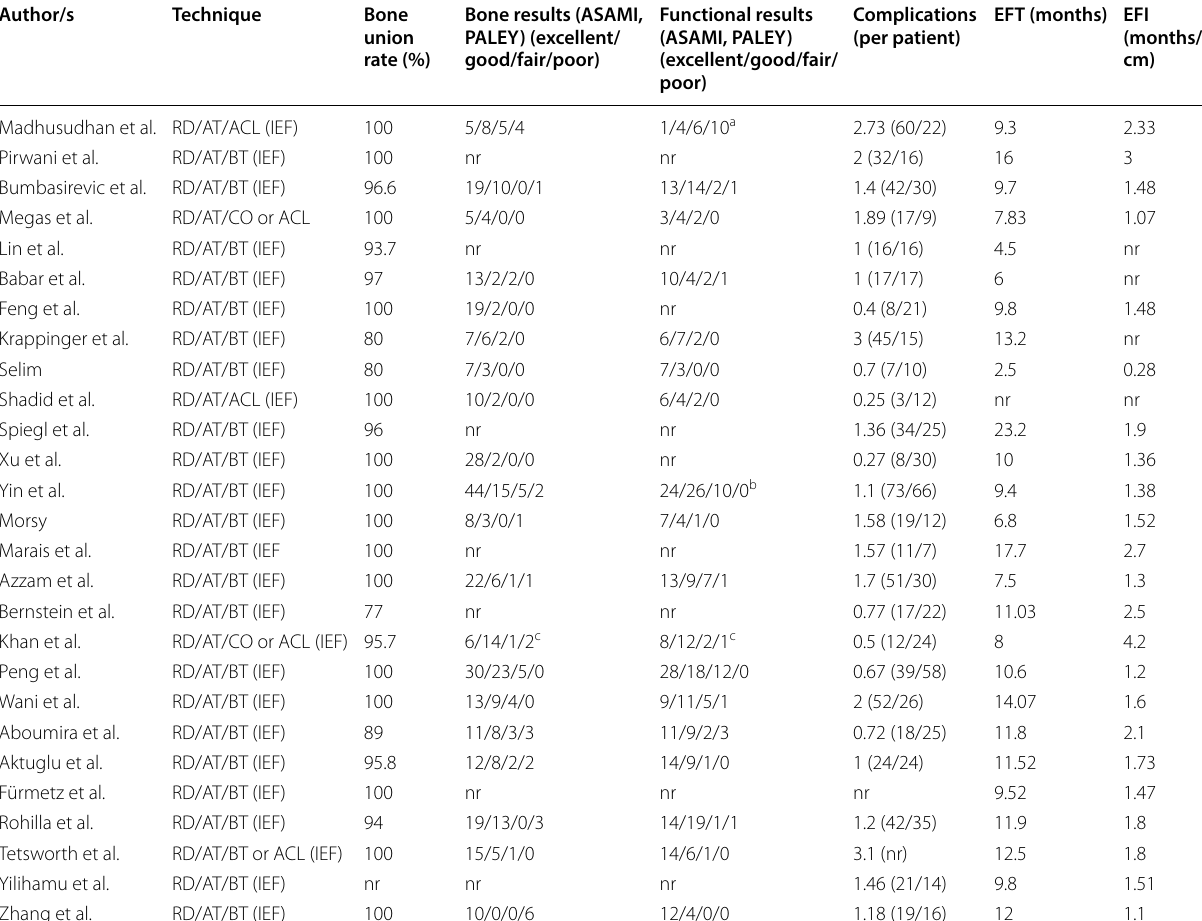
Table 2 Interventions and outcomes of included